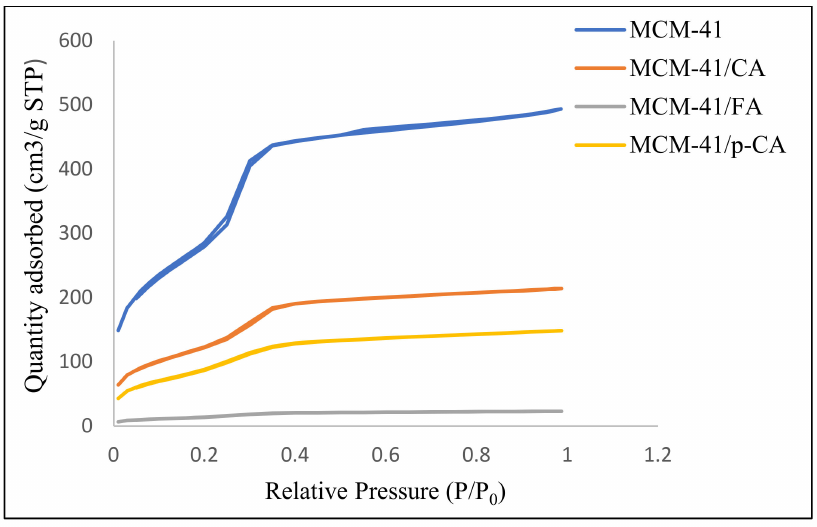
Figure 4. Adsorption isotherms recorded on materials MCM41, MCM-41/CA, MCM-41/p-CA and MCM-41/FA.